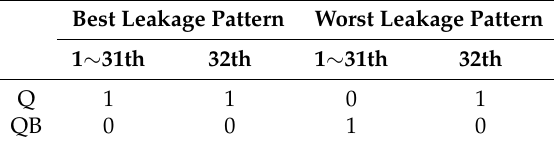
Table 1. Data pattern dependency for leakage current at bit line (BL) (read bit line (RBL) in 8T) when reading the 32th